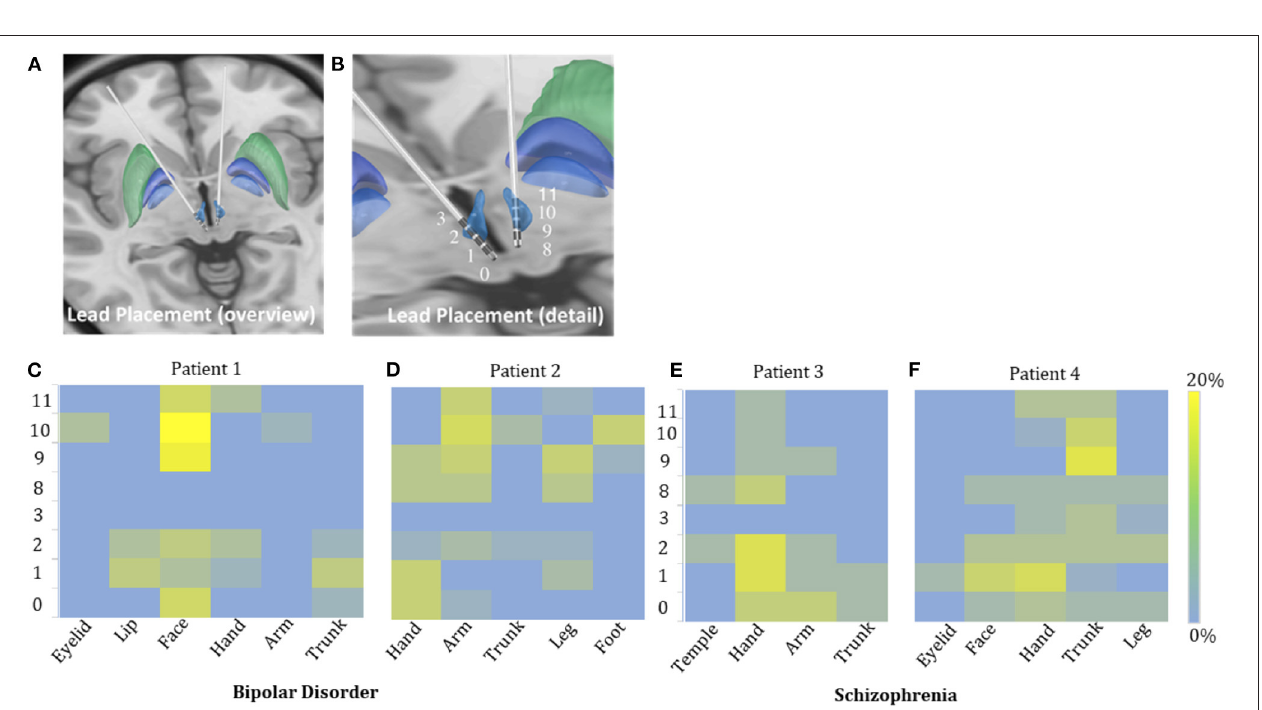
FIGURE 2 | Possible sensory projections in the habenula. Overview (A) and detailed view (B) of the deep brain stimulation lead placement. The letters marked beside the cathodes (C–F) indicate the most frequently reported body part affected by numbness. The colors box indicated the percentage of numbness occurrence at different contact and body parts in numbness trials for each patient. The contacts 0, 1, 2, and 3 were located in the right habenula from ventral to dorsal, and the contacts 8, 9, 10, and 11 were located in the left habenula from ventral to dorsal.